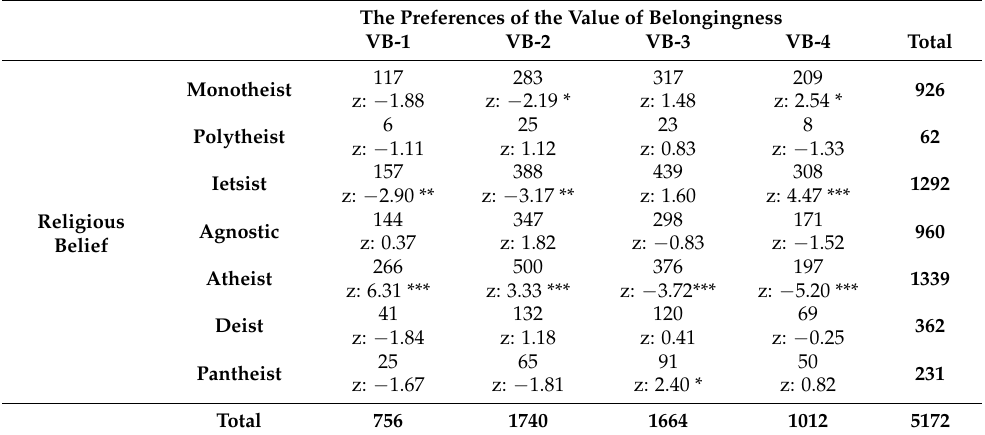
Table 1. Relationship between the preference for the value of belongingness (VB) and religious